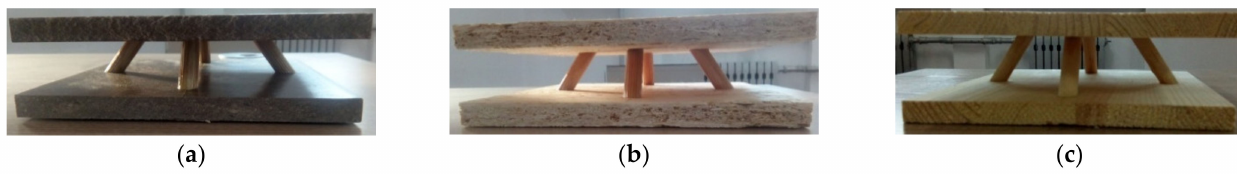
Figure 3. Fabrication of pyramid sandwich structure. ( a ) WPC + Birch; ( b ) OSB + Birch; ( c ) Larch +